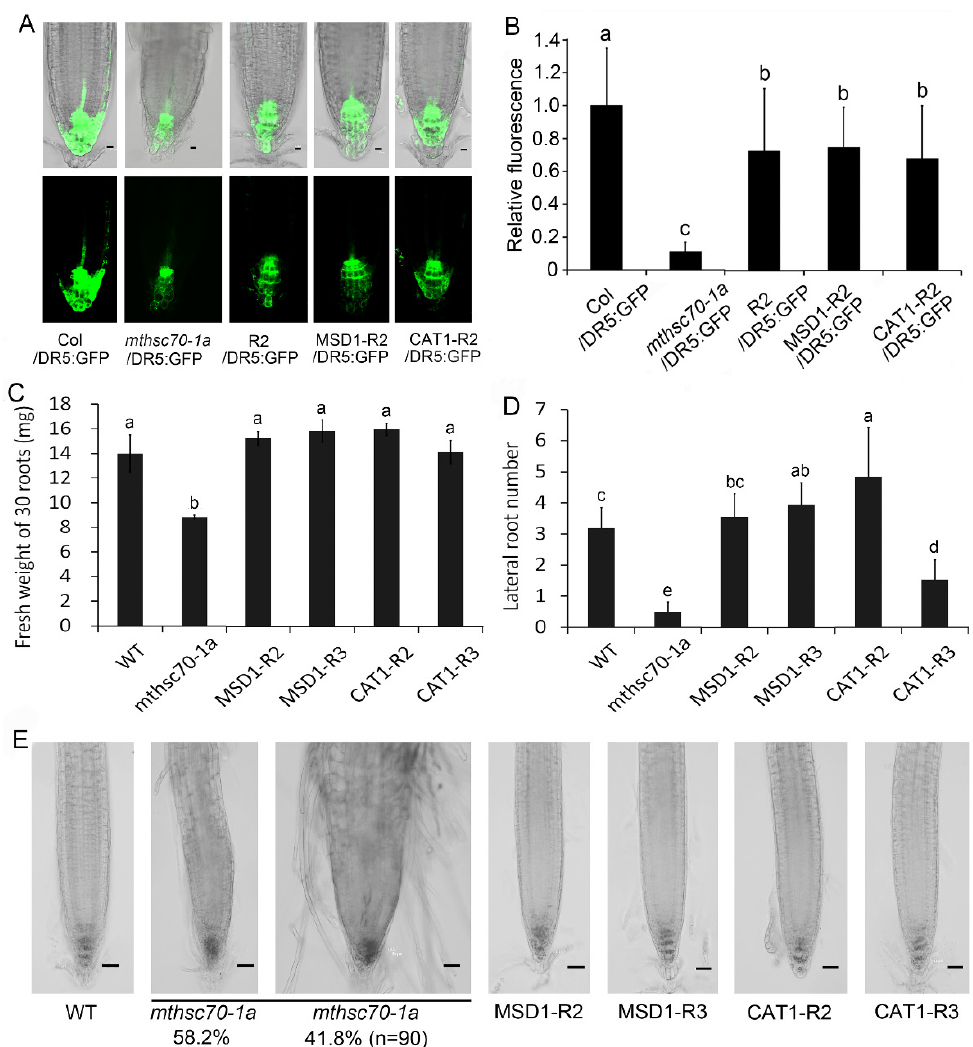
Figure 10. Introduction of the mtHSC70-1 , MSD1 or CAT1 gene rescued the auxin response and root growth and development. ( A ) Root tips of 5 days old transgenic seedlings harboring DR5:GFP were observed using a LSCM; representative images are shown. Scale bar = 10 µ m. ( B ) The GFP fluorescence intensities were visualized with ImageJ 1.42q software (National Institutes of Health, Bethesda, MD, USA). Thirty seedlings from each genotype were analyzed. The different letters indicate significant differences (ANOVA, Tukey’s HSD test, alpha = 0.05). ( C , D ) Comparison of fresh root weight ( C ) and lateral root number ( D ) among WT, mthsc70-1a , MSD1-R2, MSD1-R3, CAT1-R2 and CAT1-R3 seedlings. The different letters indicate significant differences (ANOVA, Tukey’s HSD test, alpha = 0.05). ( E ) Representative images of root tips of 10 days old seedlings with different genotypes. Scale bar = 40 µ m. The roots of the mtHSC70-1 mutants were divided into two types according to their width ( ≤ 140 µ m or >140 µ m) in the transition position of the meristem zone and elongation zone. The percentages below the images represent the ratio of two types of roots. n, the total number of roots analyzed. Col/ DR5:GFP , Col plants harboring DR5:GFP ;